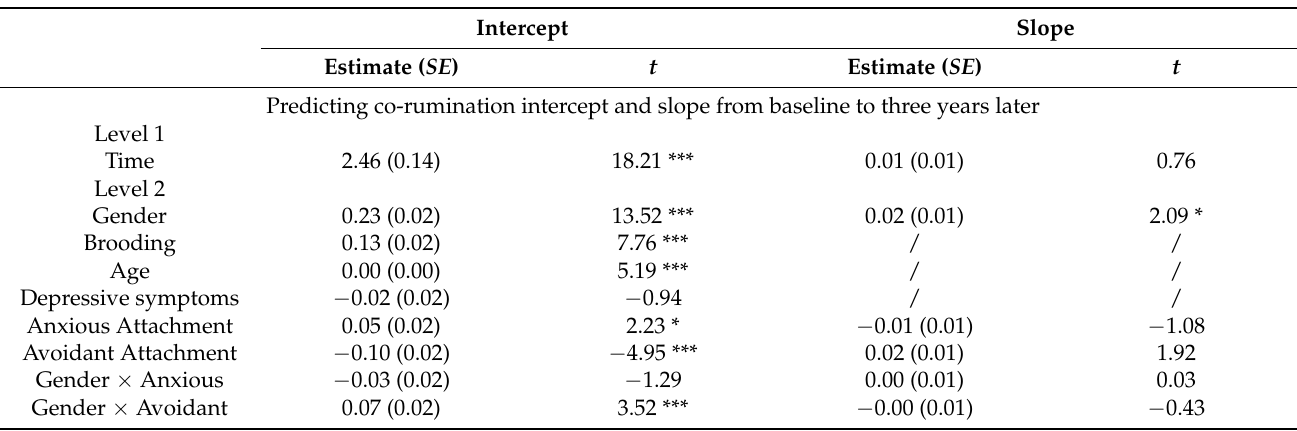
Table 6. Multi-level analyses predicting co-rumination trajectories as a function of the covariates, gender, and anxious and avoidant